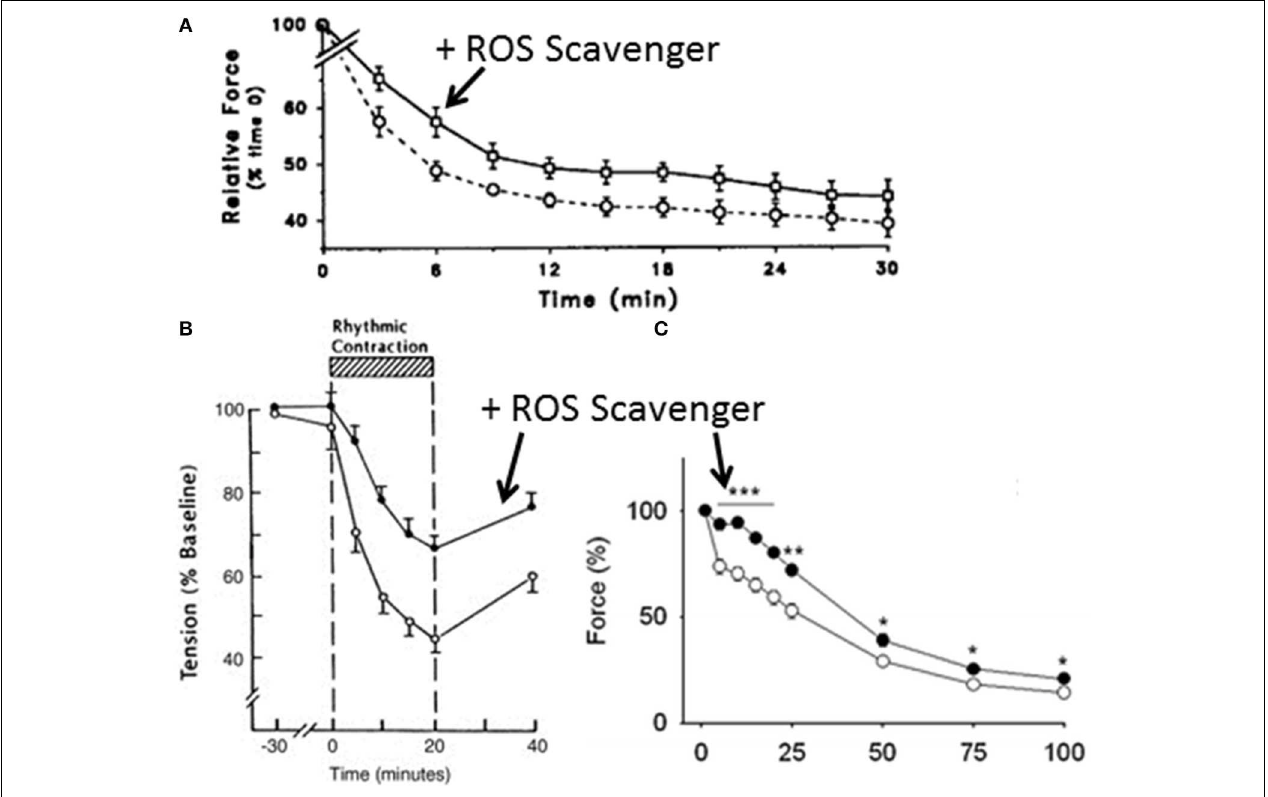
FIGURE 1 | Effect of reactive oxygen species scavengers on fatigue. (A) Effect of pretreatment with ROS scavenger, N -acetylcysteine (circles) vs. control (squares) on the fatigue profile of the tibialis anterior muscle in humans stimulated at 10Hz with a surface electrode. The drop in force was significant under both conditions but the force was greater with N -acetylcysteine treatment. Reprinted from Reid et al. (1994) with rights and permission from American Society for Clinical Investigation. (B) Effect of the N -acetylcysteine on the development of diaphragm fatigue in an anesthetized intact rabbit preparation. Reprinted from Shindoh et al. (1990) with permission. (C) Effect of N -acetylcysteine on the development of fatigue in isolated mouse extensor digitorum longus muscle. Reprinted from Katz et al. (2014) with permission. * , ** and *** indicate significantly different from corresponding control value (open circles) at p < 0 . 05 , p < 0 . 01 , and p < 0 . 001